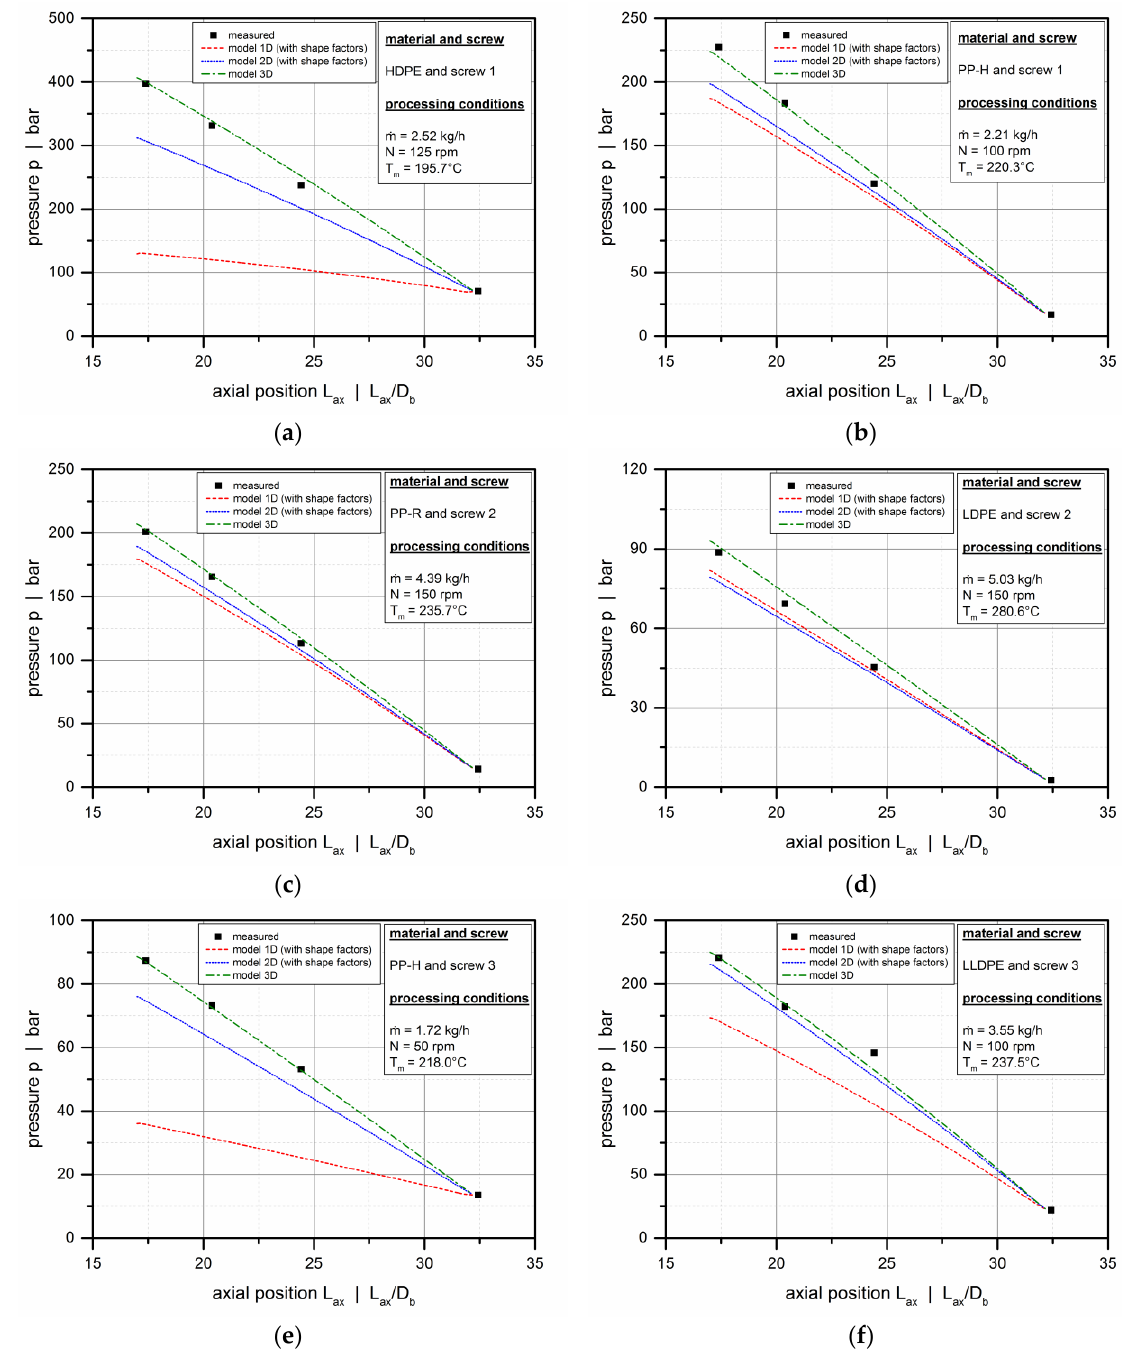
Figure 12. Comparison between experimental data and solutions from model 1D, model 2D, and model 3D. Axial pressure profiles for various experimental setups: HDPE, screw 1, N = 125 rpm ( a ); PP-H, screw 1, N = 100 rpm ( b ); PP-R, screw 2, N = 150 rpm ( c ); LDPE, screw 2, N = 150 rpm ( d ); PP-H, screw 3, N = 50 rpm ( e ); LLDPE, screw 3, N = 100 rpm ( f ).